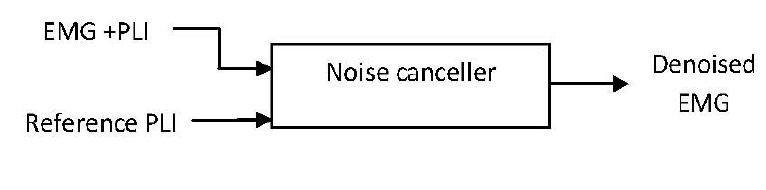
Figure 1. General block diagram of PLI cancelling